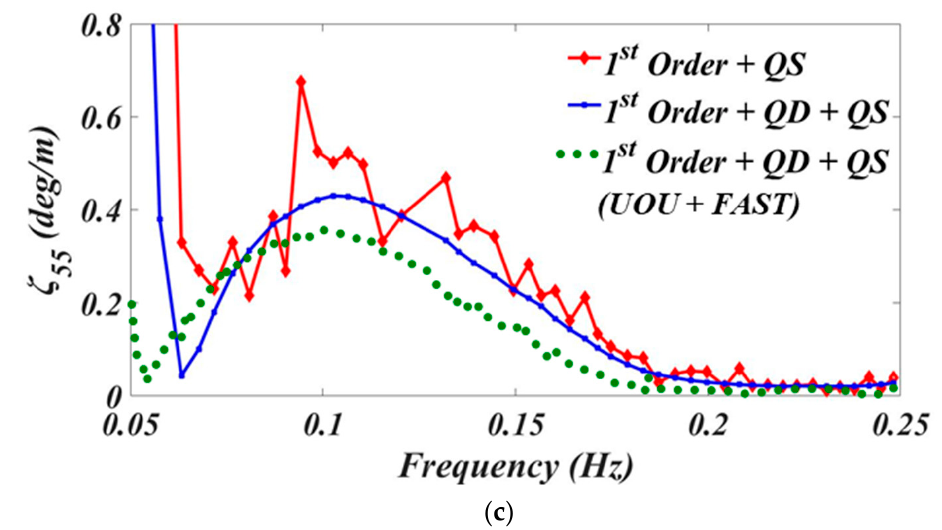
Figure 11. The effect of quadratic damping on ( a ) the surge, ( b ) the heave, and ( c ) the pitch modes, respectively.